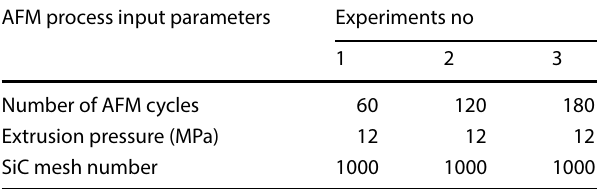
Table 3 Levels of AFM process input parameters used in machining experiments